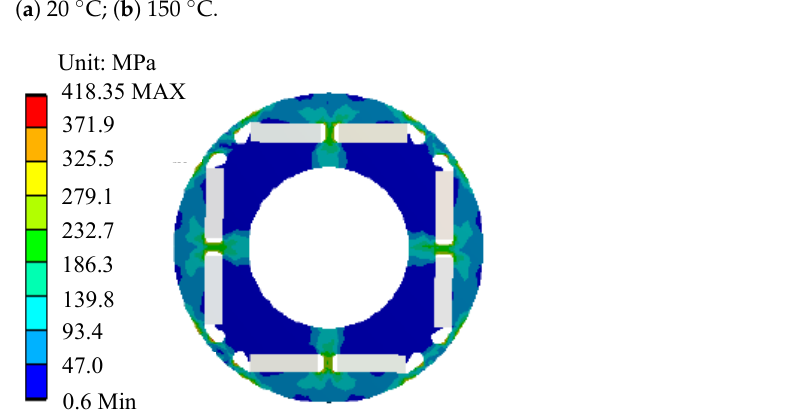
Figure 21. The equivalent stress distribution of sleeve at different temperature conditions [122]: